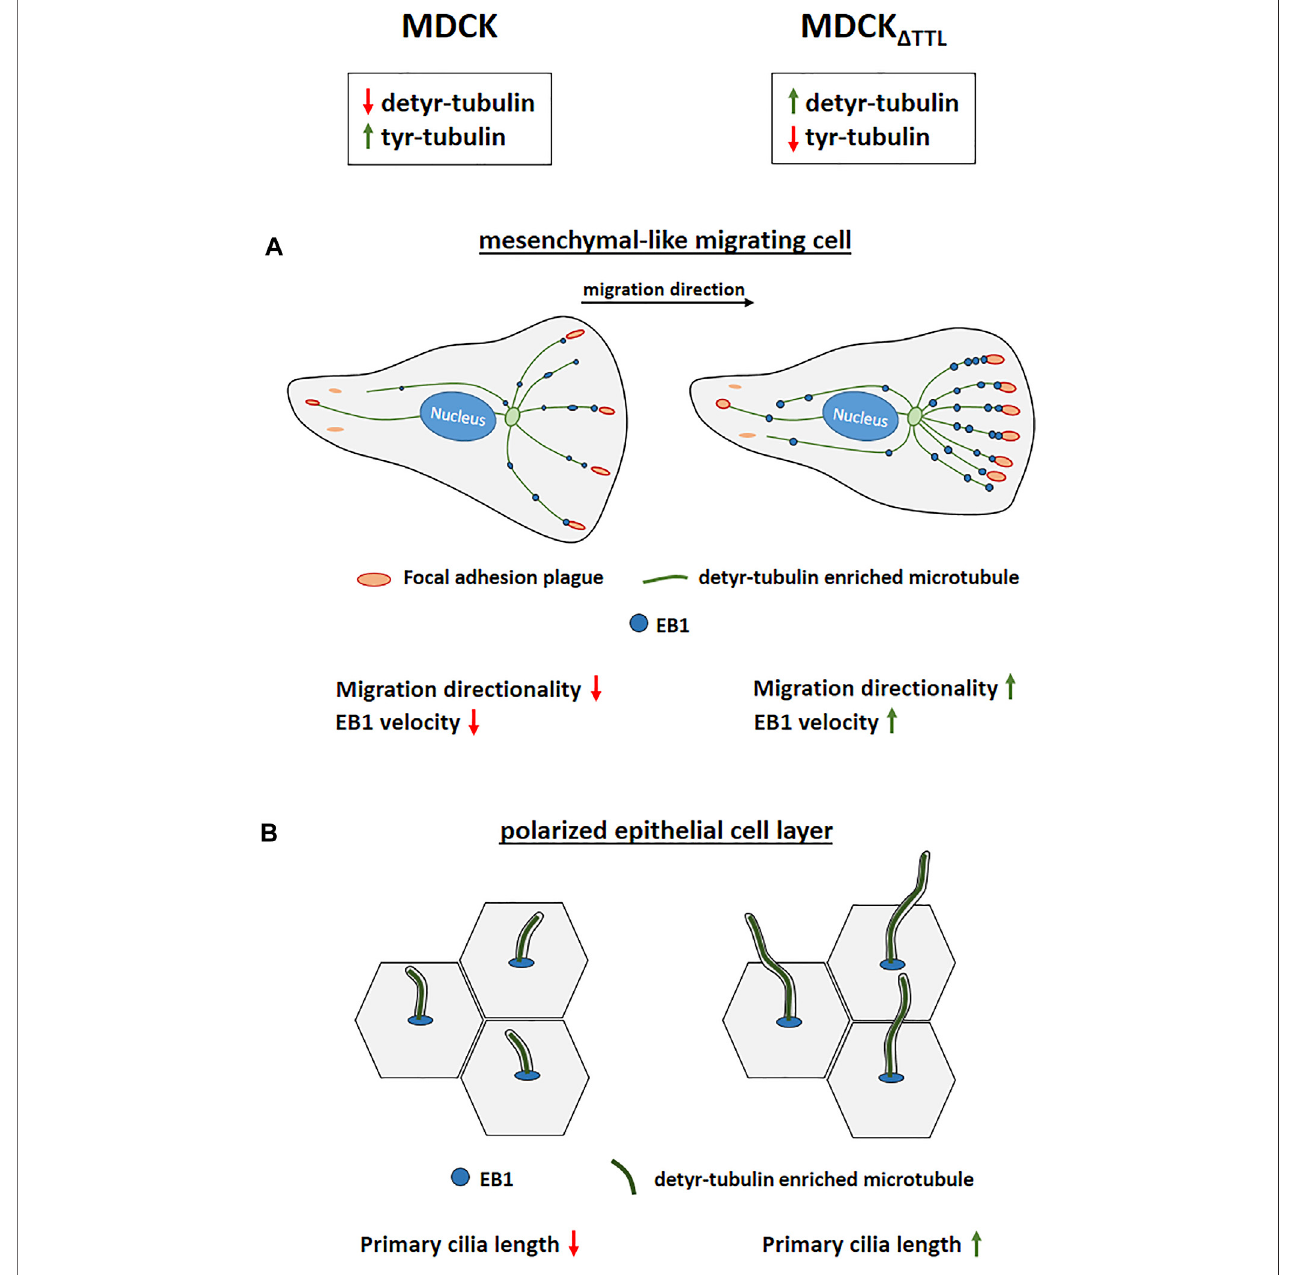
FIGURE 9 | Modulation of TTL-expression alters directional cell migration and ciliogenesis. (A) Migrating MDCK cells devoid of TTL migrate with enhanced directionality.Elevatednumbersofmicrotubulesenrichedindetyr-tubulinaredecoratedbyEB1andareincloseproximitytofocaladhesionsplacedinthedirectionofcell movement. (B) Polarized MDCK cells devoid of TTL exhibit exceptionally elongated primary cilia.